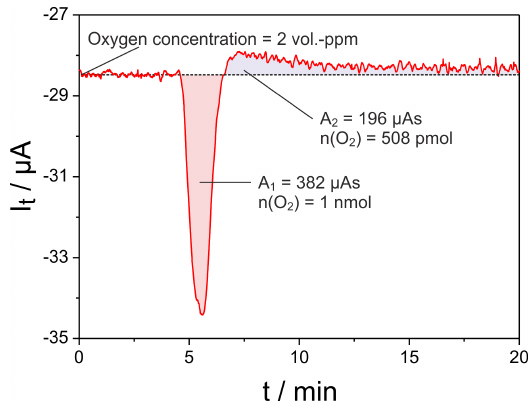
Figure 7. Oxygen titration peak measured with cell two of the setup given in Fig. 1 at U P = − 300mV; sample: 8mol-% YSZ; sample temperature 650 ◦ C; sample polarization 25mV for 10s; flow rate 50mLmin − 1